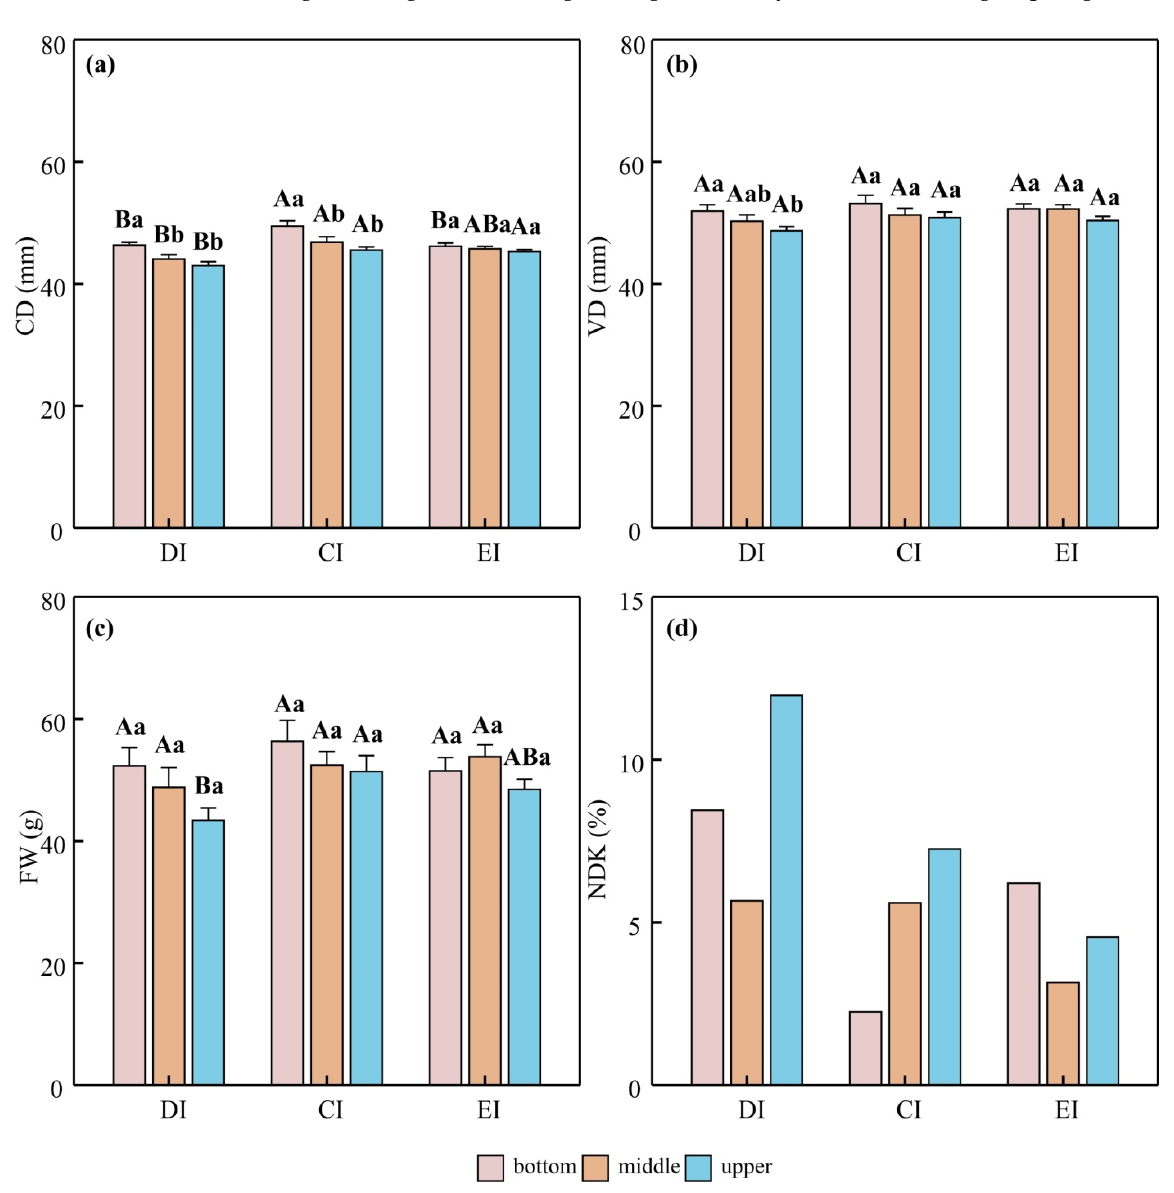
Figure 6. Morphological parameters of fruits ( a , b ), fruits weight (FW, c ) and no kernel or deflated kernel (NDK) rates ( d ) for different irrigation treatments and tree heights. Different lowercase letters indicate significant differences between different tree heights under the same treatment; different capital letters indicate significant differences between different treatments at the same tree height ( p < 0.05, mean ± standard error, n = 3~4). The total number of investigated walnut fruits were 794, 1374 and 1627 for the DI, CI and EI groups, respectively.